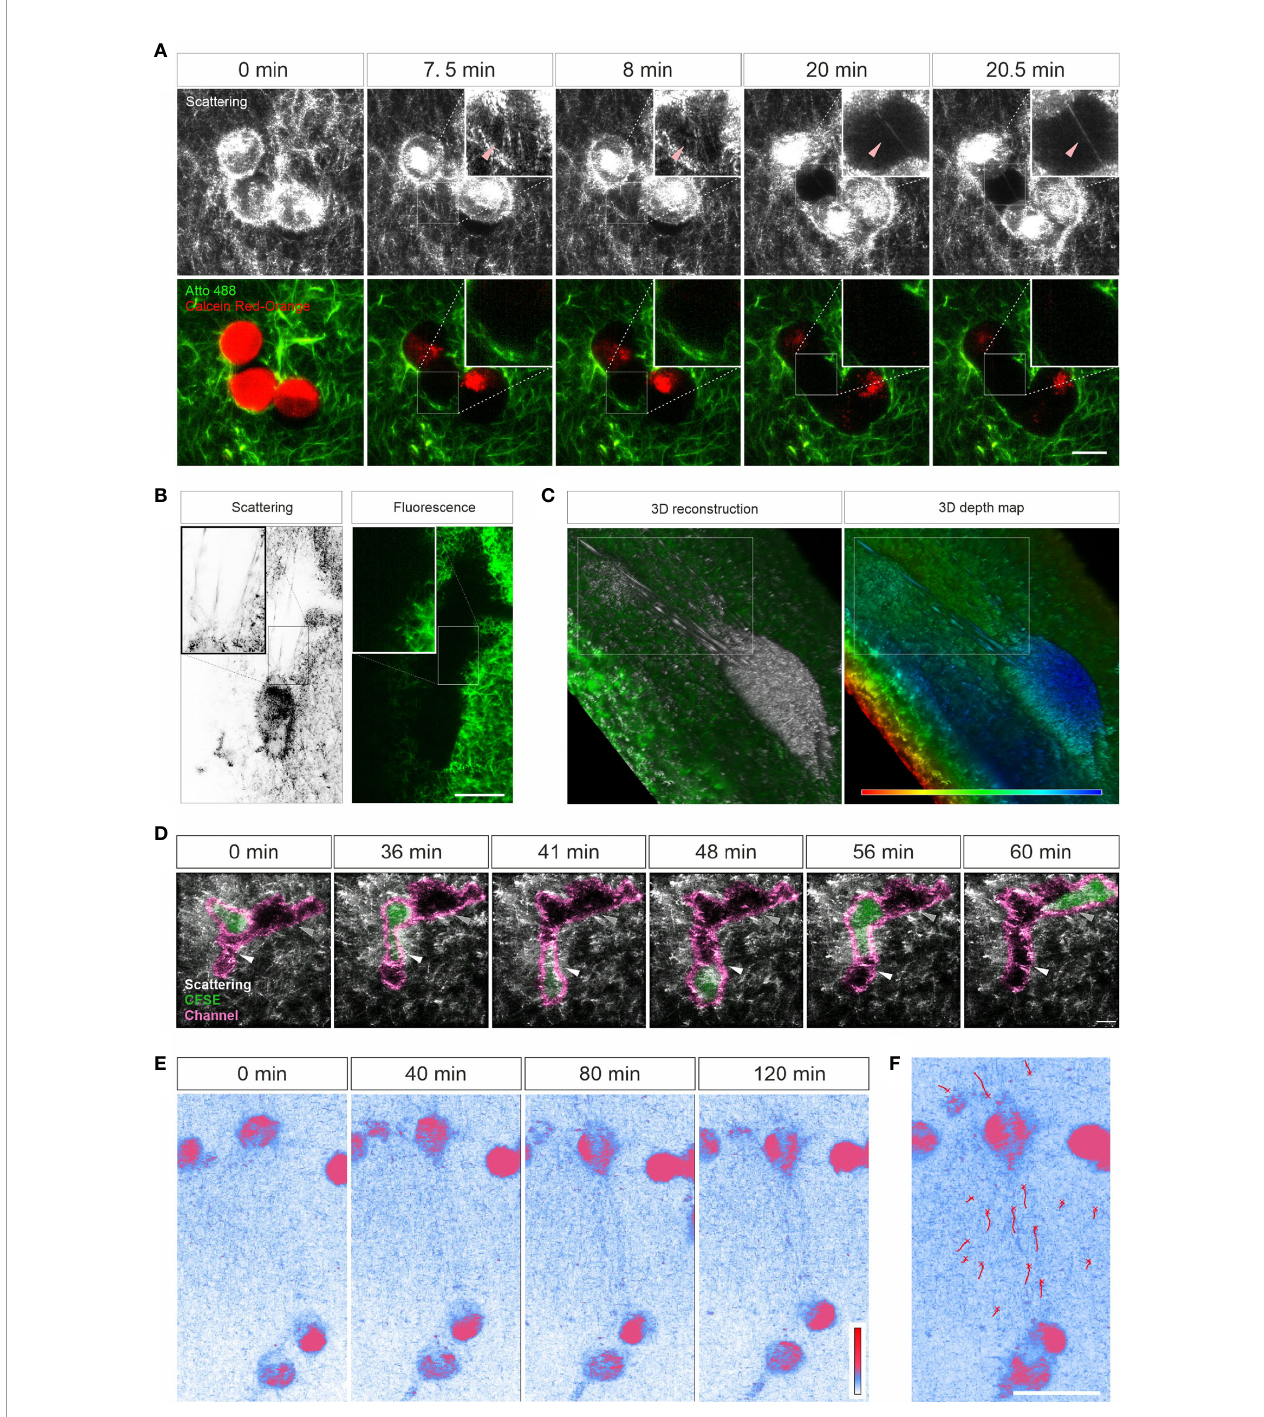
FIGURE 3 | Live cell imaging with LSSM. (A – C) Ultrathin fi lamentous structures observed with LSSM. Rat tail collagen (2 mg/ml) was fl uorescently labeled with Atto 488. Calcein-AM red-orange loaded SK-MEL-5 cells (A) or non-labeled 1.4E7 human pancreatic beta cells (B, C) were embedded in the matrix. Z-stacks with step- size of 0.82 µm for 52 slices (A) or 0.418 µm for 82 slices (B, C) were obtained using LSSM and fl uorescence modality concurrently at 37°C every 30 sec for 35.5 min (A) or every 20 sec for 10 min (B, C) . (D) T cells enter channels in ECM. Primary human CD4 + T cells were loaded with CFSE and were embedded in the collagen matrices (Bovine collagen, 2 mg/ml). Z-stacks with step-size of 1.5 µm for 70 slices were obtained using LSSM and fl uorescence modality concurrently at 37°C every 1 min for 1 hour. (E, F) Cell-induced displacement of collagen fi bers. Non-labeled SK-MEL-5 cells were embedded in rat tail collagen (2 mg/ml). Z-stacks with step-size of 1 µm for 295 slices were obtained using LSSM at 37°C every 1 min for 2 hours. Scale bars are 20 m m. Representative events from three independent experiments are